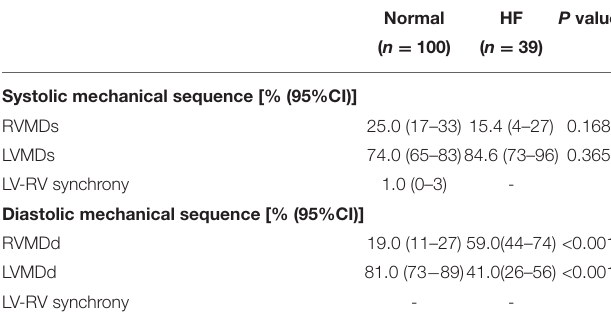
TABLE 5 | Analysis of the ventricular mechanical sequence- normal humans vs HF patients.